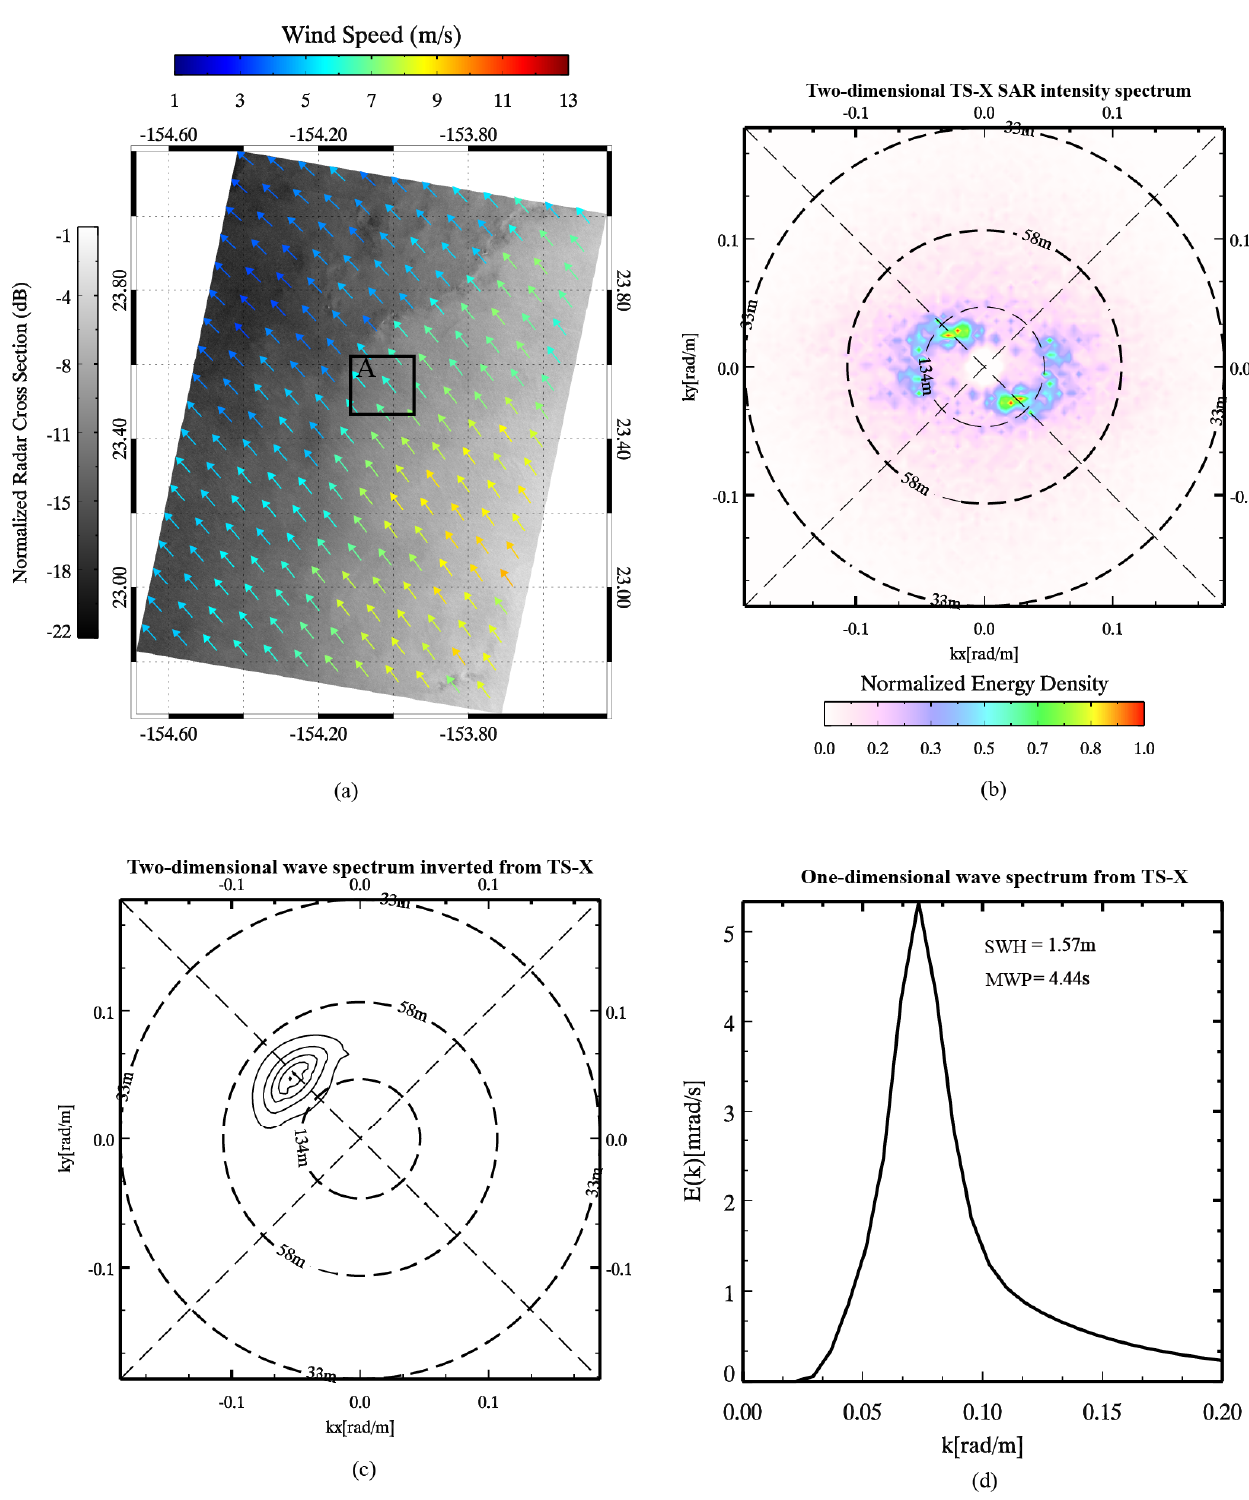
Figure 3. A case, taken at 4:19 p.m. UTC on 13 December 2010, showing the wind field and wave retrieval: ( a ) wind field retrieval; ( b ) two-dimensional TS-X intensity spectrum; ( c ) two-dimensional wave spectrum retrieval inverted from TS-X; and ( d ) one-dimensional wave spectrum retrieval with SWH and